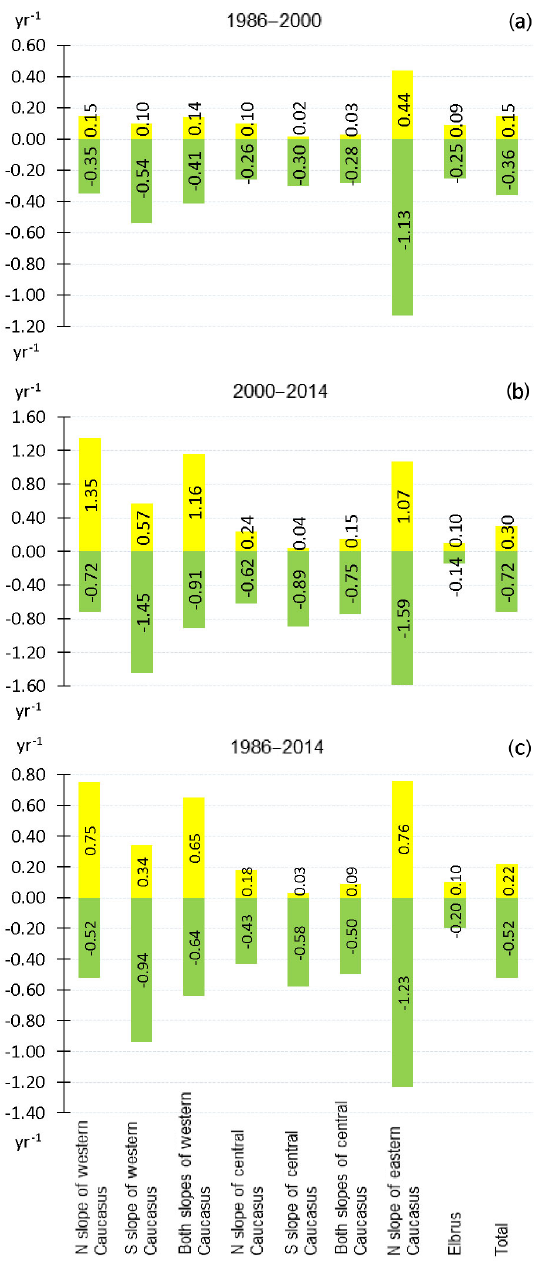
Figure 4. Supra-glacial debris cover increase (yellow) and glacier area decrease (green) rates (%) in the Greater Caucasus by slopes, sections and mountain massifs in 1986–2000 (a) , 2000–2014 (b) and 1986–2014 (c)